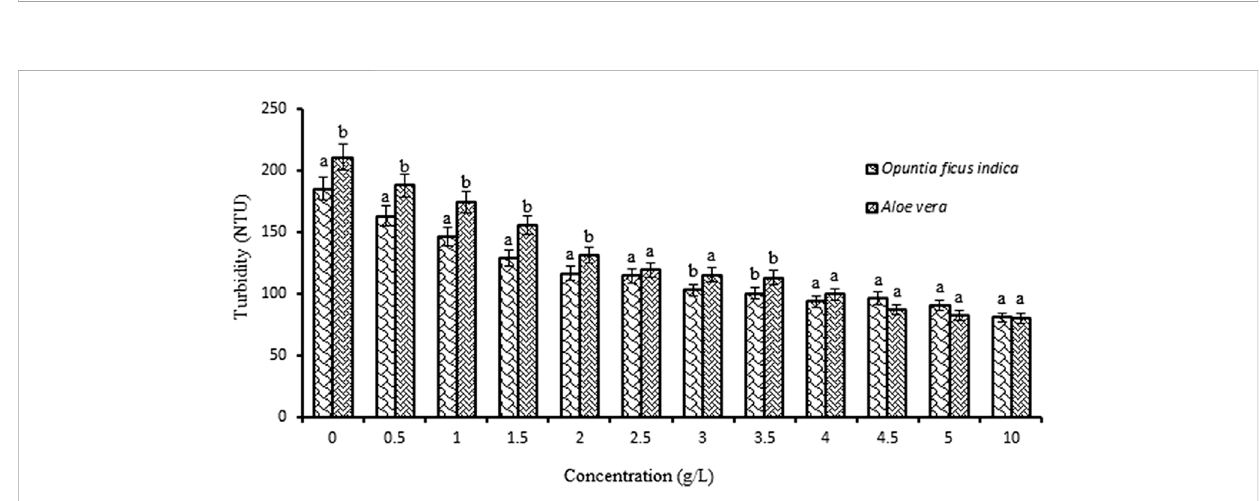
FIGURE 5 Measurement of turbidity of water samples treated with different concentration of cactus ( Opuntia fi cus indica ) and Aloe vera